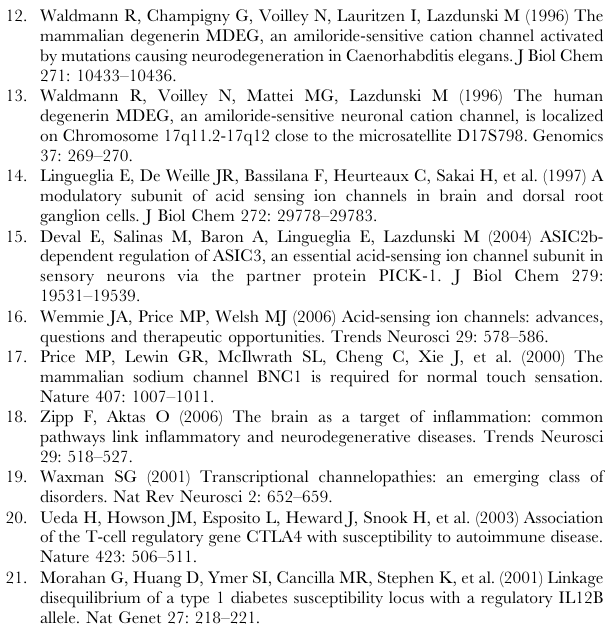
Table S4 R 2 coefficient for each pair of studied SNPs (in- formation from the founders of the Nuoro population and from the Caucasian population).